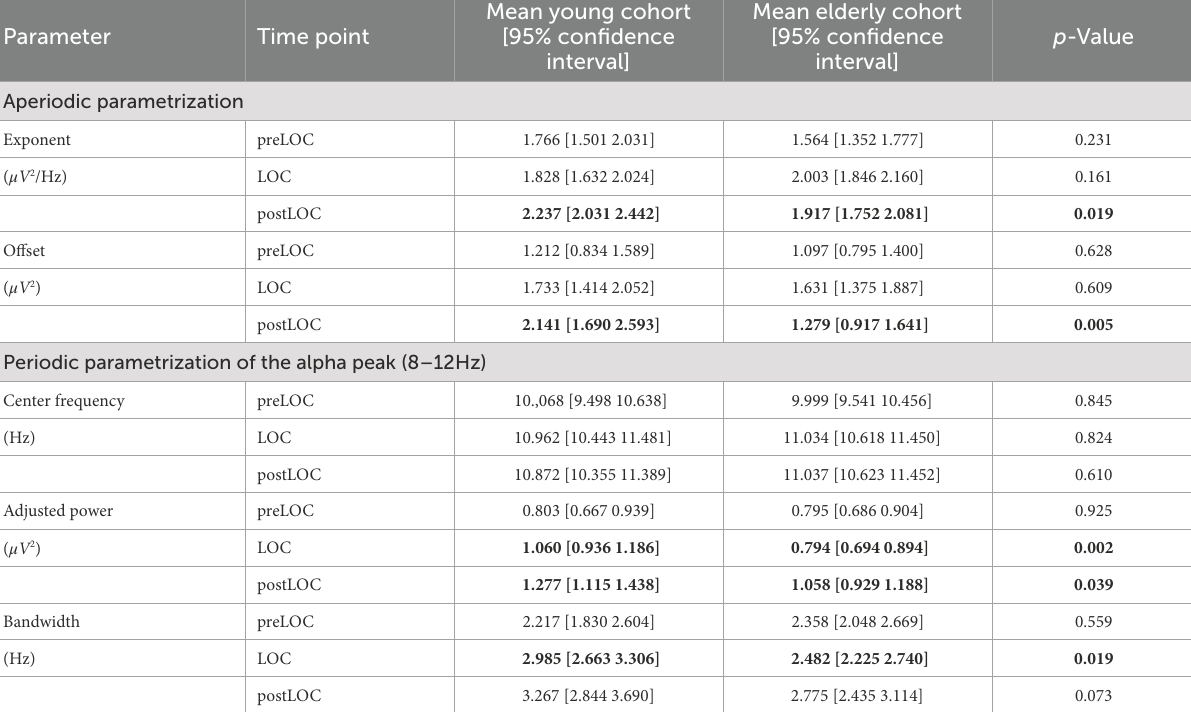
Results with p-values below 0.05 were represented